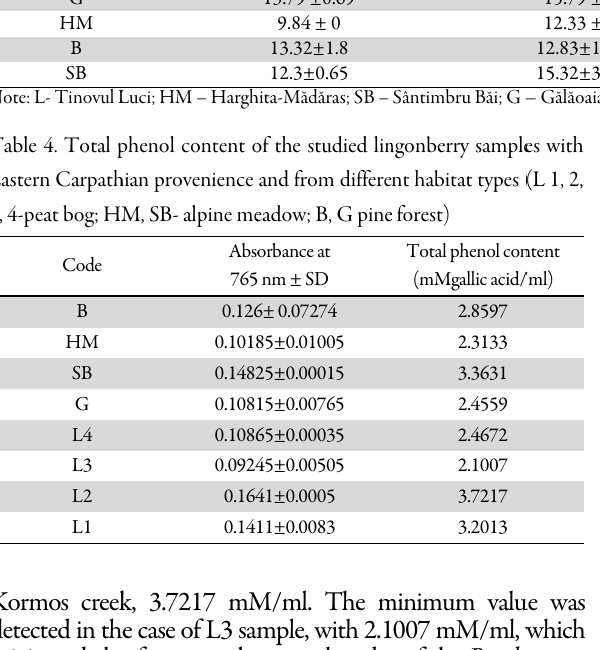
Fig. 2. Dendrogram generated with IBM SPSS 20.0 using